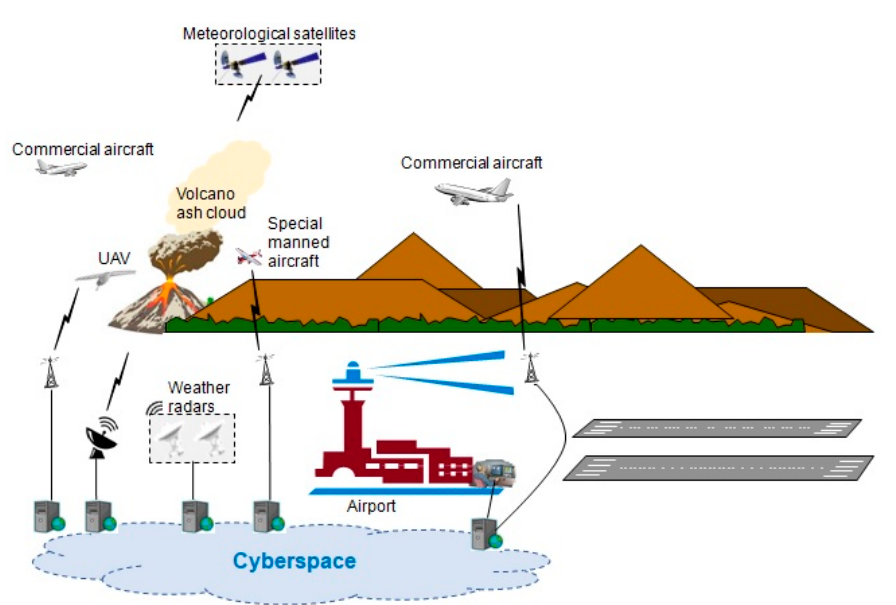
Figure 15. Cyber-physical view of Scenario 2.